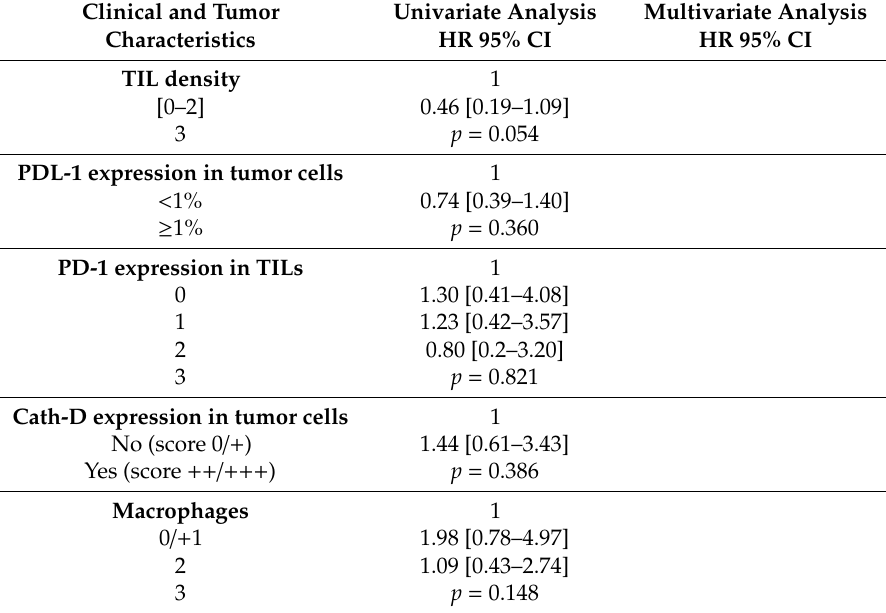
Table 4. Univariate and multivariate analyses for overall survival (OS). Clinical and Tumor Characteristics